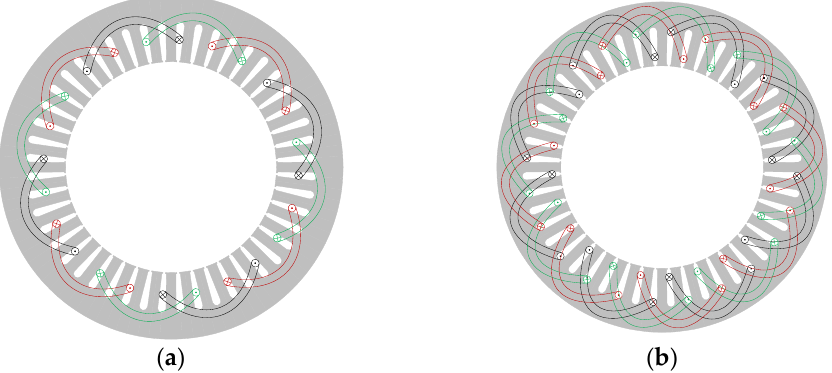
Figure 36. Winding layouts of remaining winding set in DTP machines: ( a ) DTP-SF; ( b ) DTP-DS.